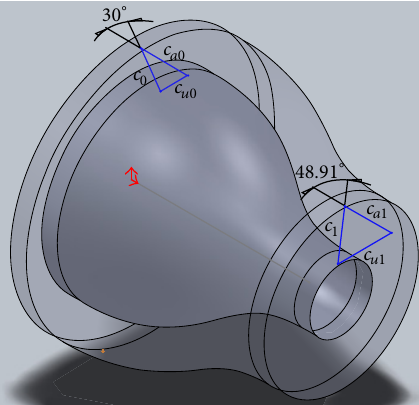
Figure 5: Three-dimensional model of the inlet annular duct with velocity triangles.